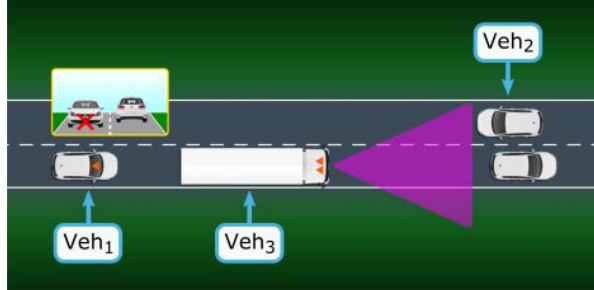
Figure 2. Sketch of see through use case: Veh 1 plans to overtake Veh 3 .